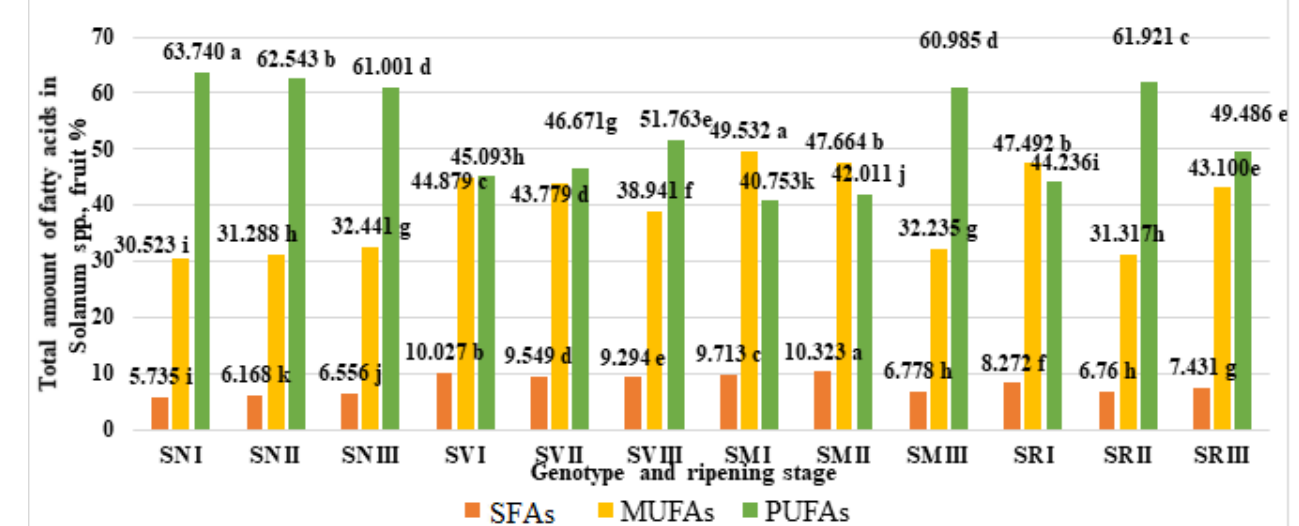
Figure 4. Total amounts of saturated (SFA), monounsaturated (MUFA), and polyunsaturated (PUFA) fatty acids in Solanum spp. fruit, %, in different ripening stages. Note: Percentages followed by different letters are statistically different ( p < 0.05); S. retroflexum –(SR), S. melanocerasum –(SM), S. nigrum –(SN), S. villosum –(SV); ripening stages I, II, III.